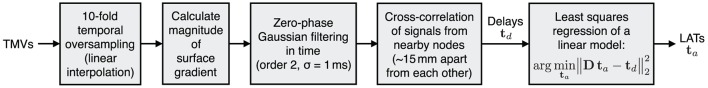
Delay-based LAT estimation. D is a difference matrix to obtain pair-wise delays from LATs.